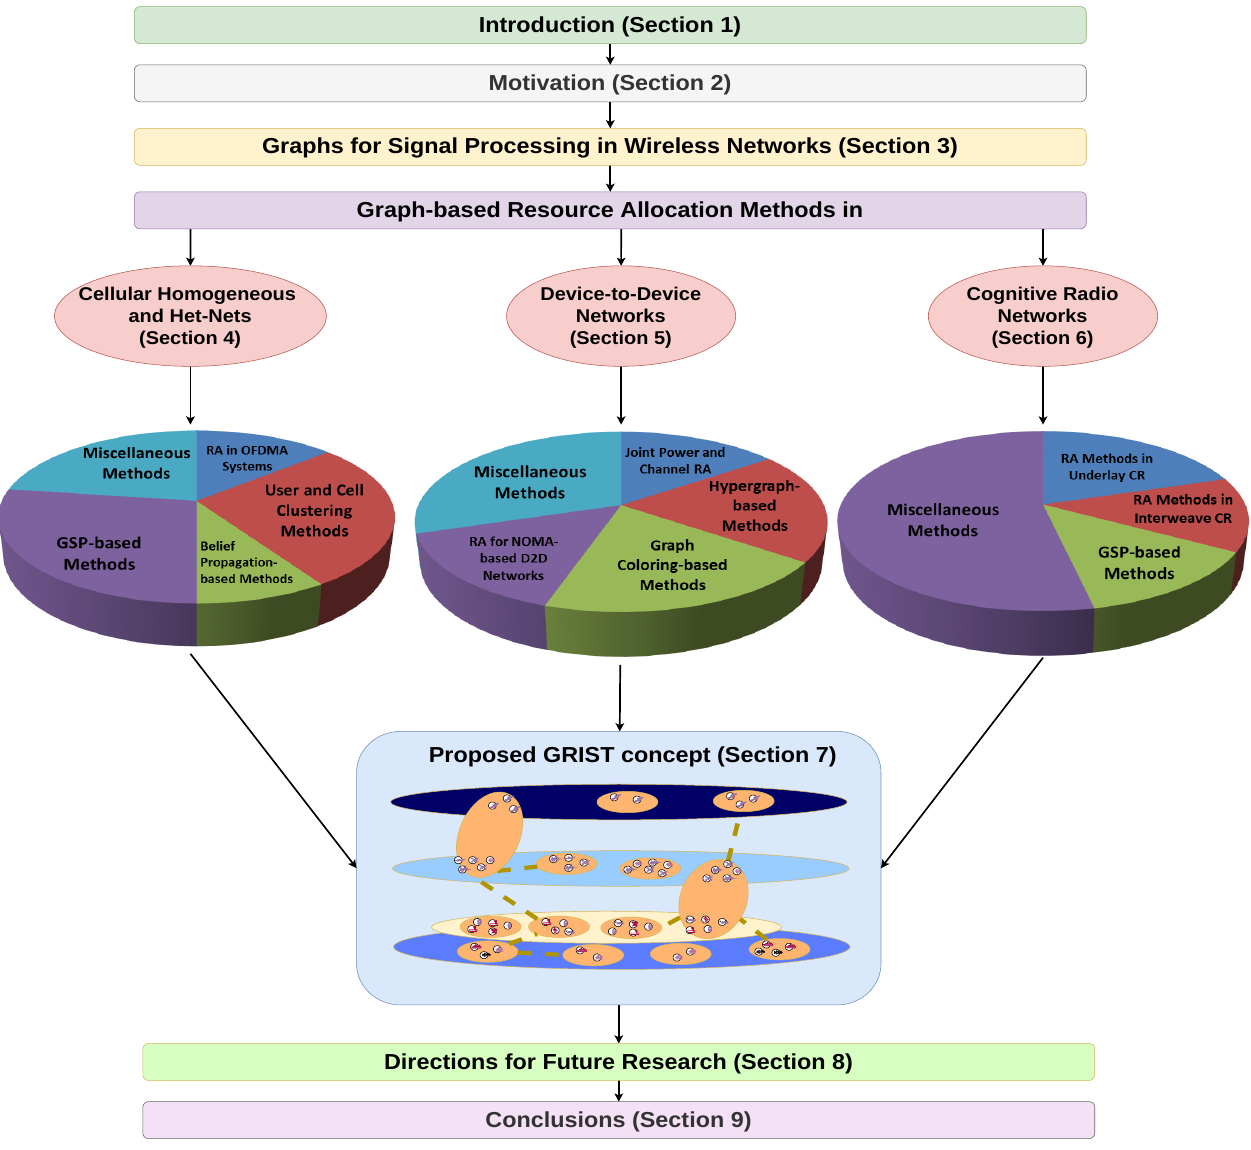
Figure 2. Graph-based RA in advanced wireless